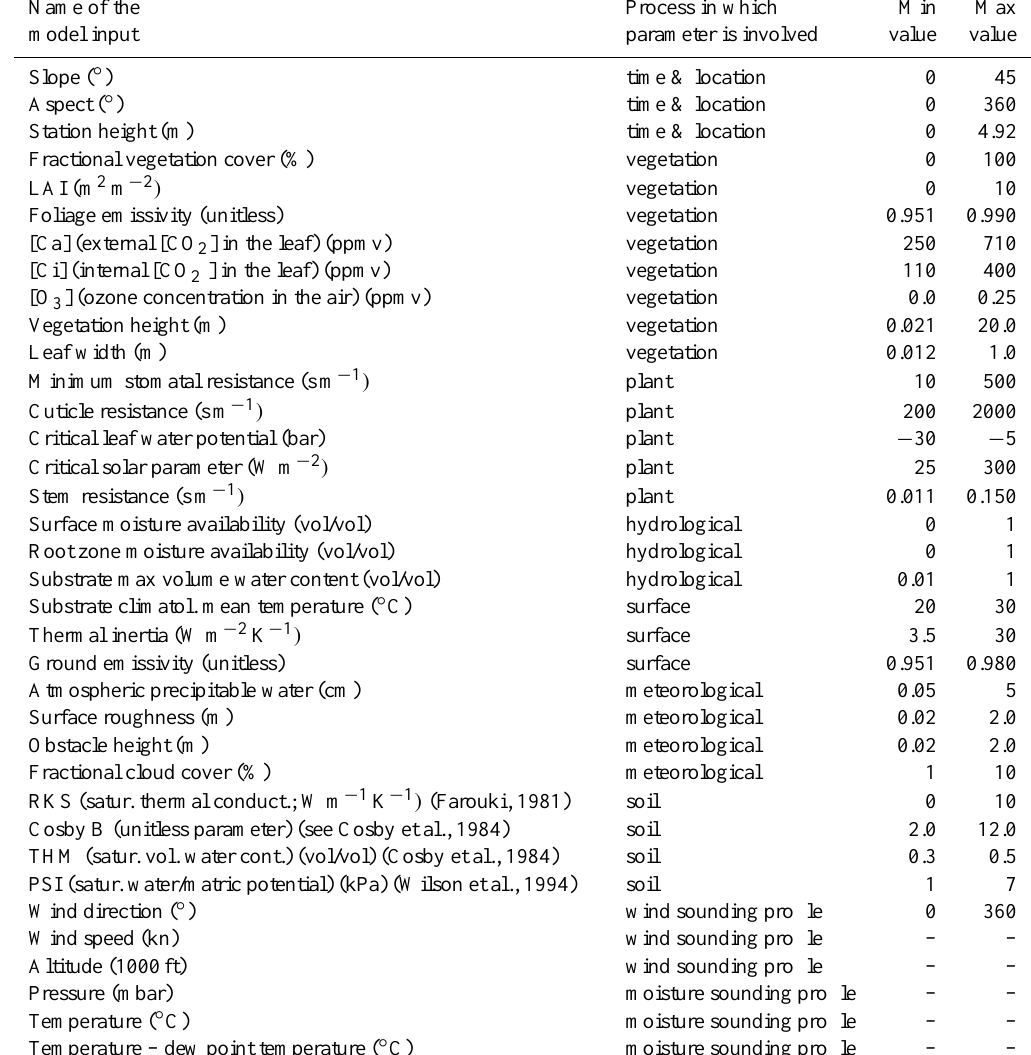
Table 1. Summary of the main SimSphere inputs. The units of each of the model inputs are given in parentheses where applicable. Name of the Process in which